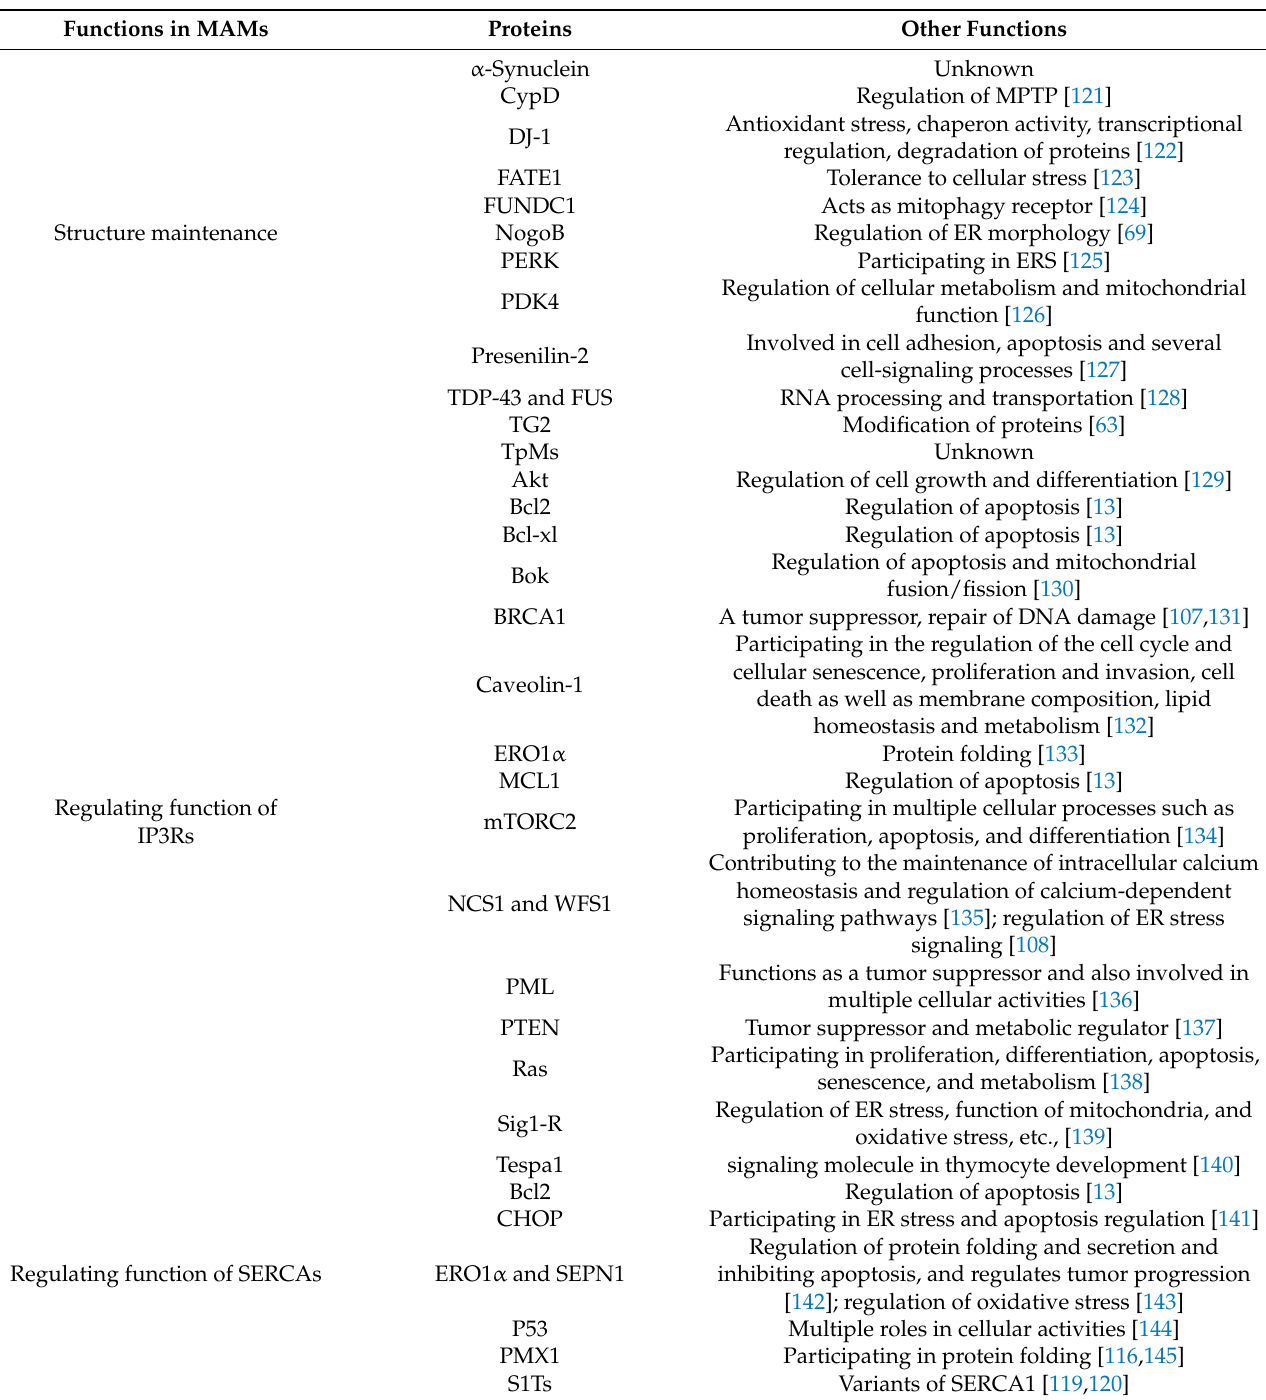
Table 1. Proteins that play roles in MAMs structure and function